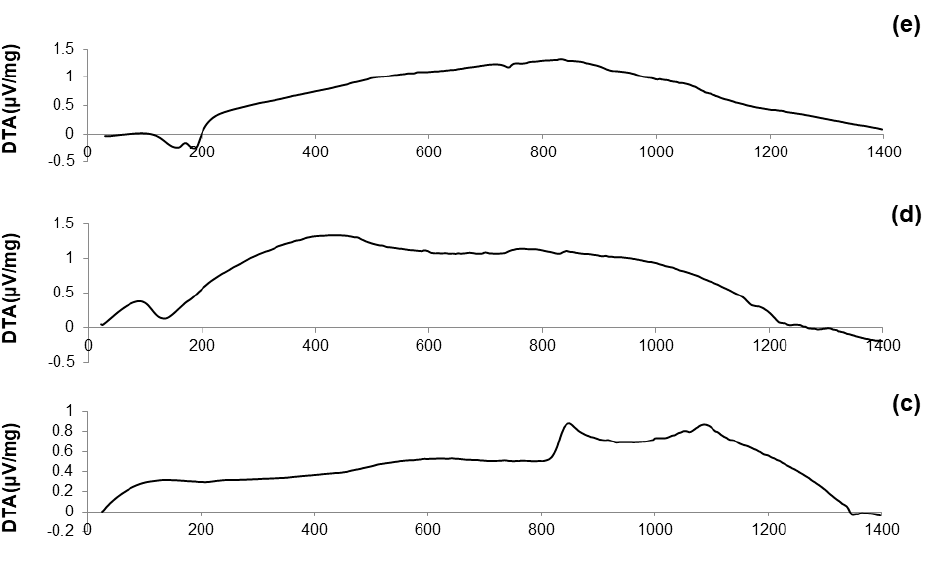
Figure 3. DTA plots of: ( a ) 60S40C-air (measurement performed in air); ( b ) 60S38C2Fe-air (measurement performed in air); ( c ) 60S38C2Fe-Ar (measurement performed in argon); ( d ) 60S30C10Fe-air (measurement performed in air); and ( e ) 60S30C10Fe-Ar (measurement performed in argon). Considering the oxide composition of 60S40C, it was reasonable to associate the exothermic crystallization peak (T x = 850 °C, see Figure 3a) to the development of wollastonite (CaSiO 3 ) crystals. Table 2. Characteristic temperatures of the calcined materials determined (when possible) from DTA (T g , T x , T c and T m ) and HSM plots (T FS and T MS ). Sample